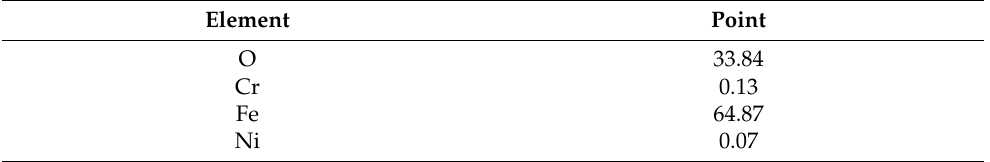
Table 3. EDS point analysis in Figure 4d (wt.%).